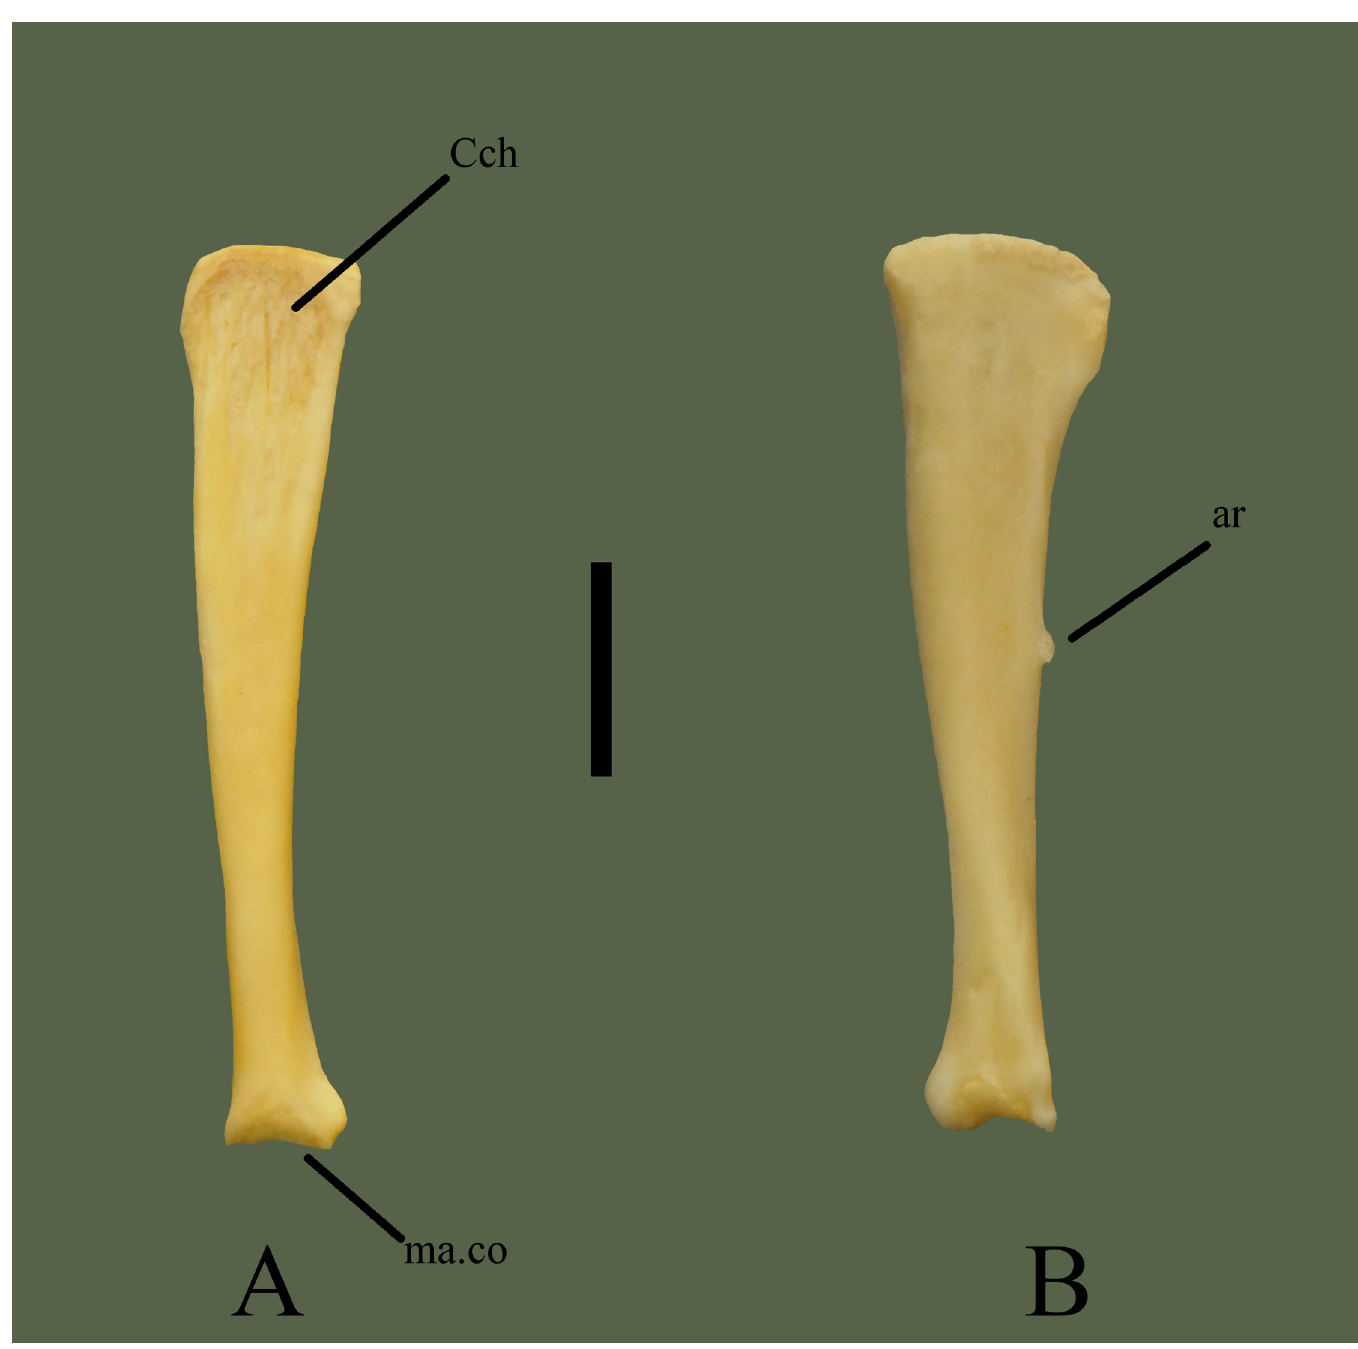
Fig 4. Right quadrate (ETVP 3295) in dorsal (A) and ventral (B) view. Anterior is to the top. Scale bar = 5 mm. Abbreviations: ar = articulatory process of quadrate; Cch = conch; ma.co = mandibular